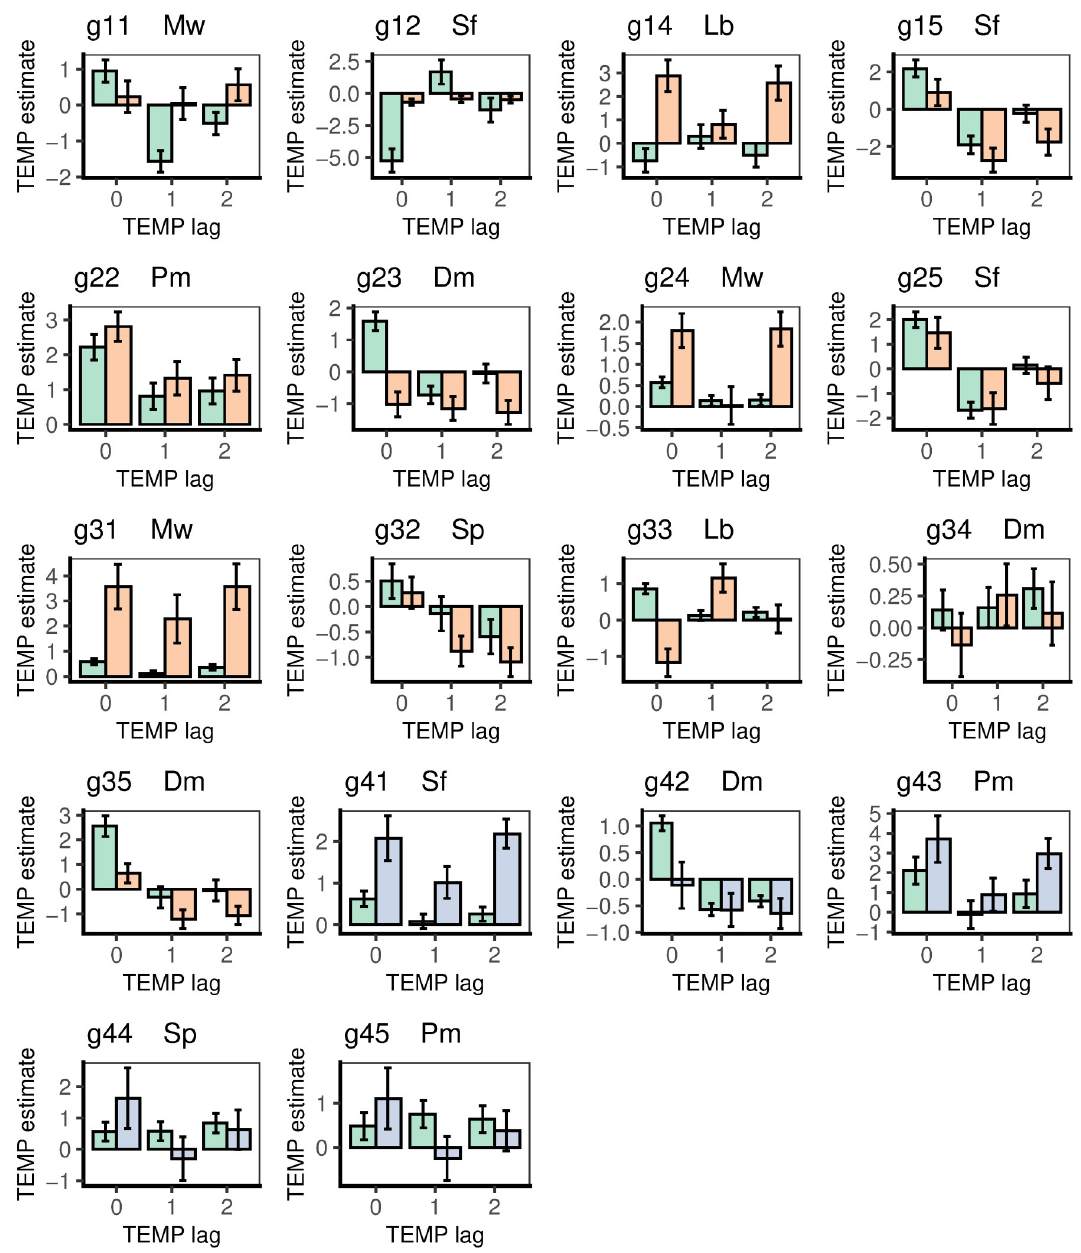
Fig 5. Mean ± SE coefficients (slopes) of gthi regressed on logger temperature (TEMP). TEMP was lagged at 0-, 1- and 2-days, in the wet (green bars) and dry (orange bars) periods, for the 18 trees taken for the time-series analyses. There were no dry-period time- series estimates for station 4, but these are predicted here (blue bars) from the species’ relationships to maximal diurnal girth change. Bands are listed in Table 4 with individual tree codes.